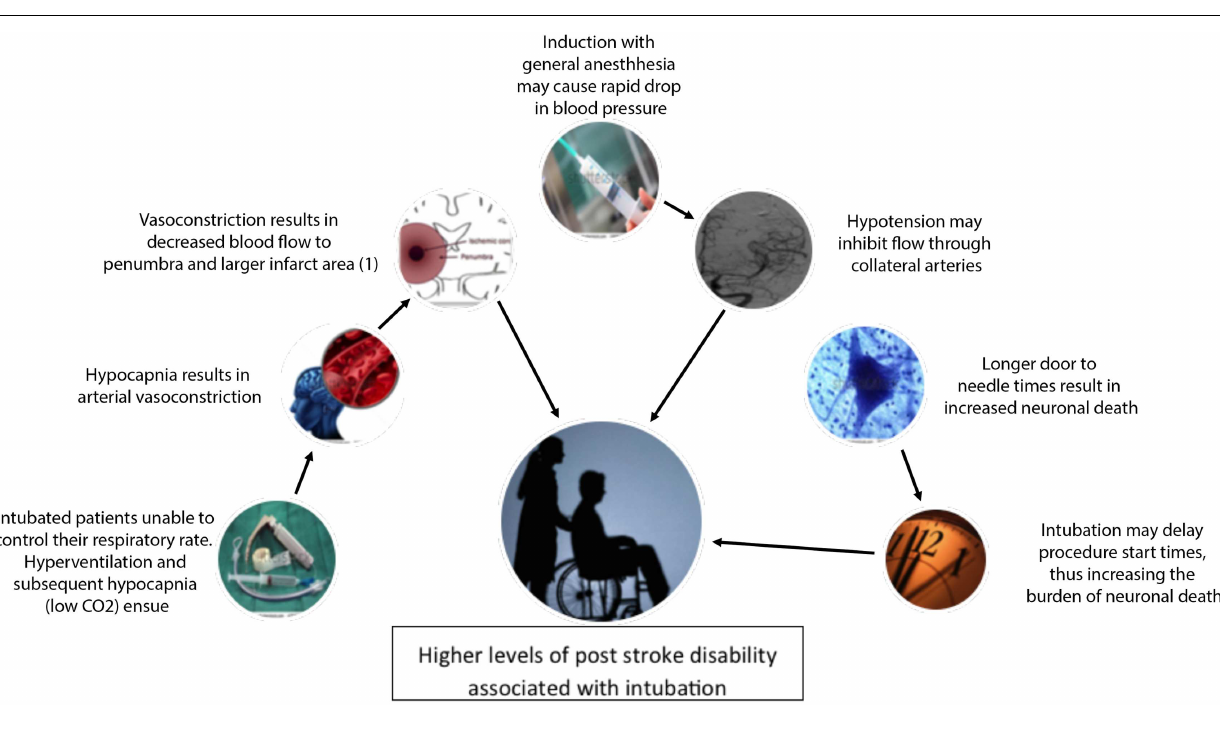
Table 1 | Relationship between time of symptom onset and functional outcome (measured by modified Rankin scale), after reperfusion therapy with IV-tPA .